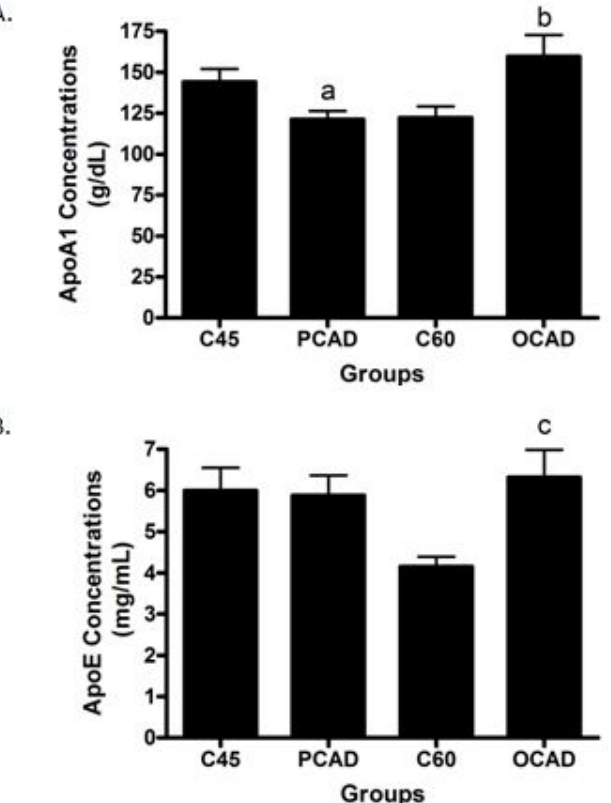
Figure 4. ( A ) Apo-A1 and ( B ) Apo-E concentrations in cases and control subjects. a p = 0.019 compared to C45; b p = 0.016 compared to C60; and c p = 0.004 compared to C60. Apo-A1 and Apo-E were analyzed using a t -test.